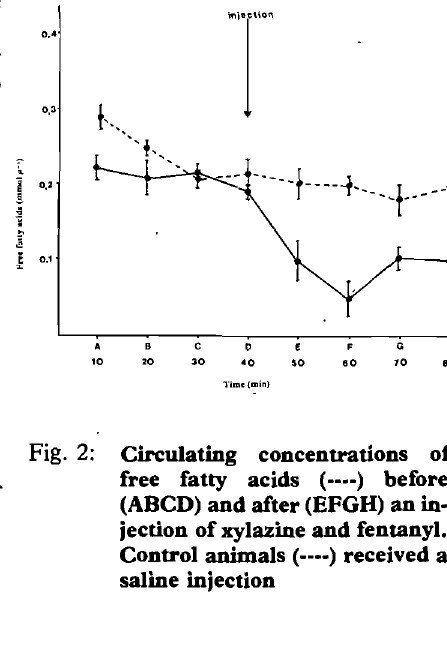
No significant changes were recorded in serum concentrations of thyroxine and triidothyronine, either after the adminis tration of the drugs, or between experi mental and control animals. Serum concentrations of progesterone and oestrogen remained constant both before and after drug administration and between control and experimental animals.